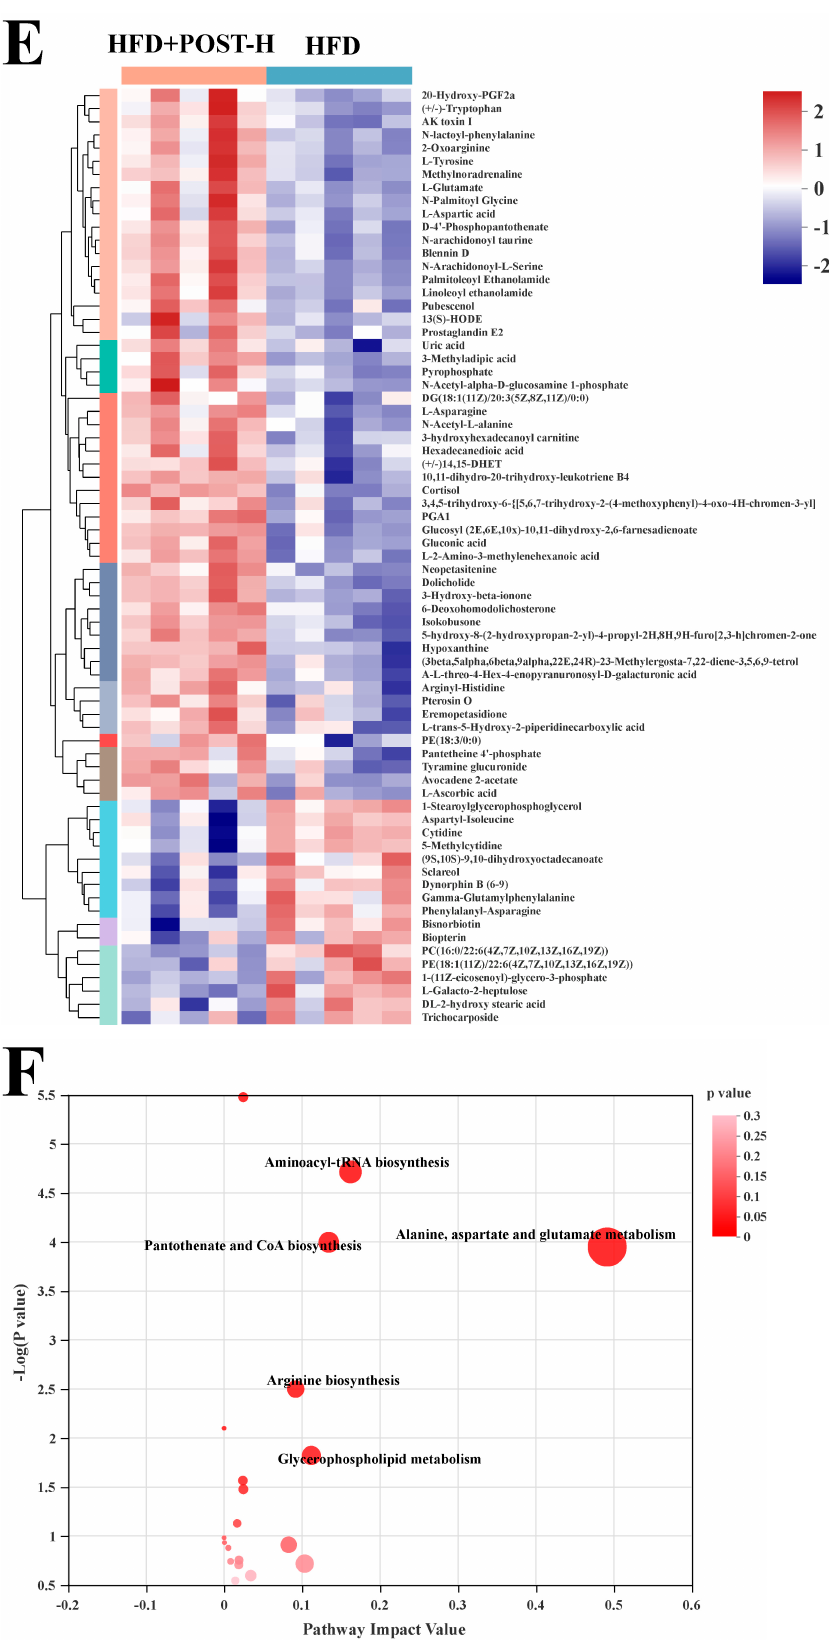
Figure 8. POST regulates hepatic metabolism (ESI-). ( A ) PCA score of the NFD, HFD and HFD + POST-H. ( B ) PLS-DA score of the NFD, HFD and HFD + POST-H. ( C ) OPLS-DA score of the HFD and HFD + POST-H. ( D ) S-loading plot based on OPLS-DA analysis of the HFD and HFD + POST-H. The red points indicate that these metabolites have a VIP value of 1 or greater, and the blue points indicate that these metabolites have a VIP value of less than 1. ( E ) Heat map of relative abundance of differential metabolites in liver between HFD and HFD + POST-H. ( F ) The effects of POST-H on liver metabolic pathways were analyzed based on KEGG.